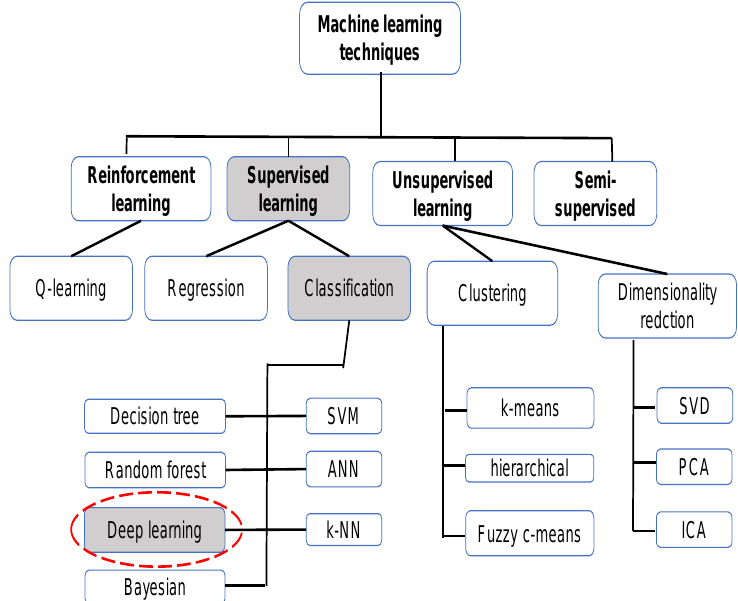
Figure 2. Machine learning techniques for CXR.